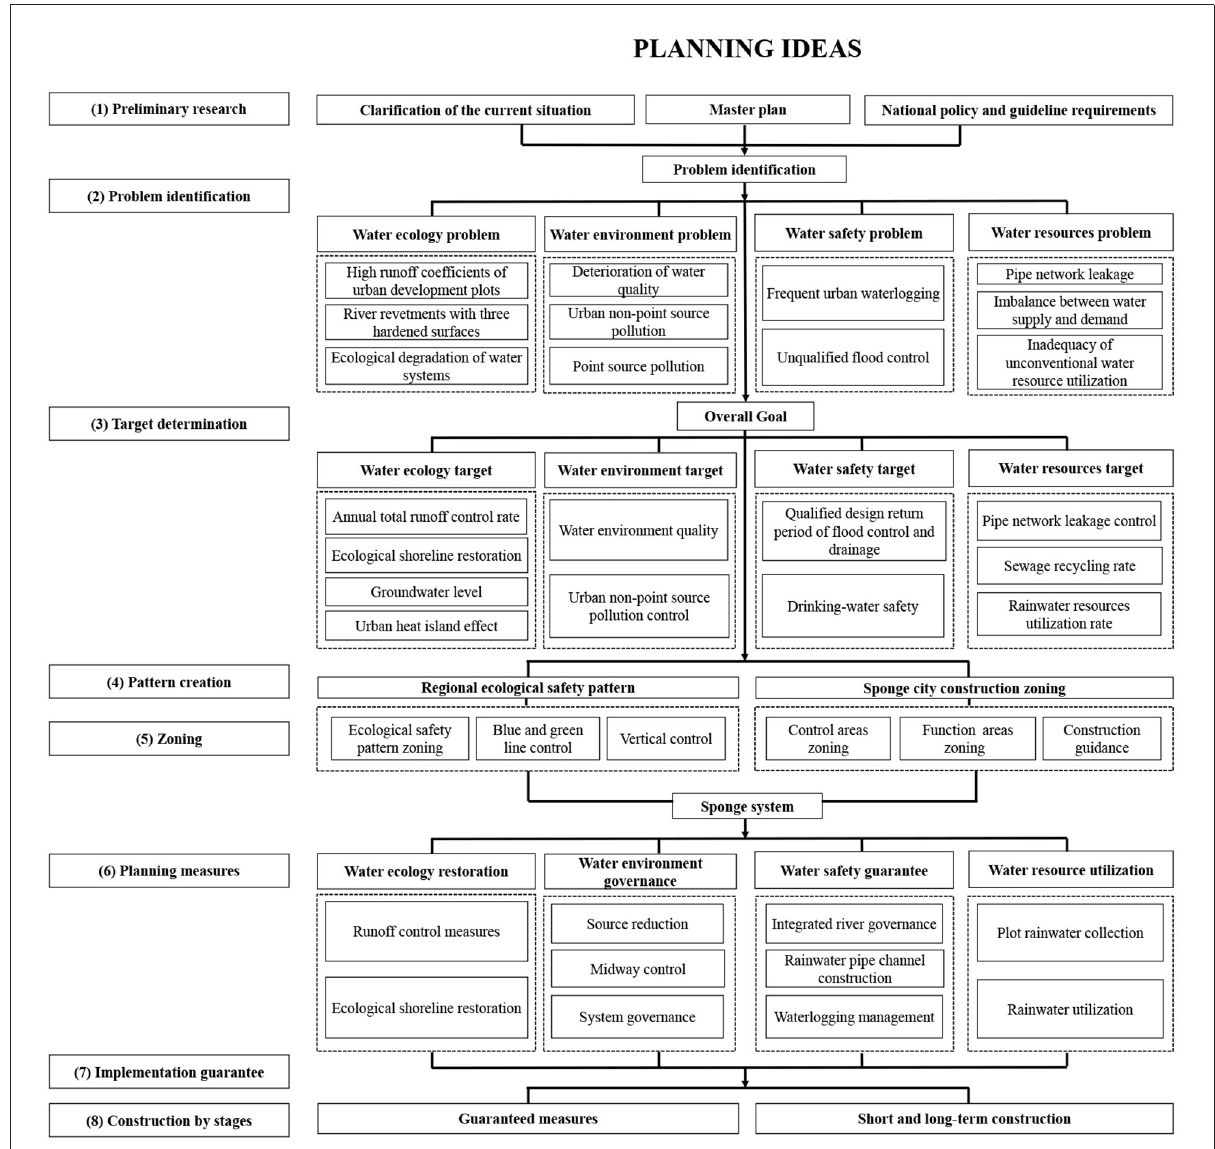
FIGURE1 Ideas for formulating the formulation of the sponge city special planning based on the framework of the “four-water